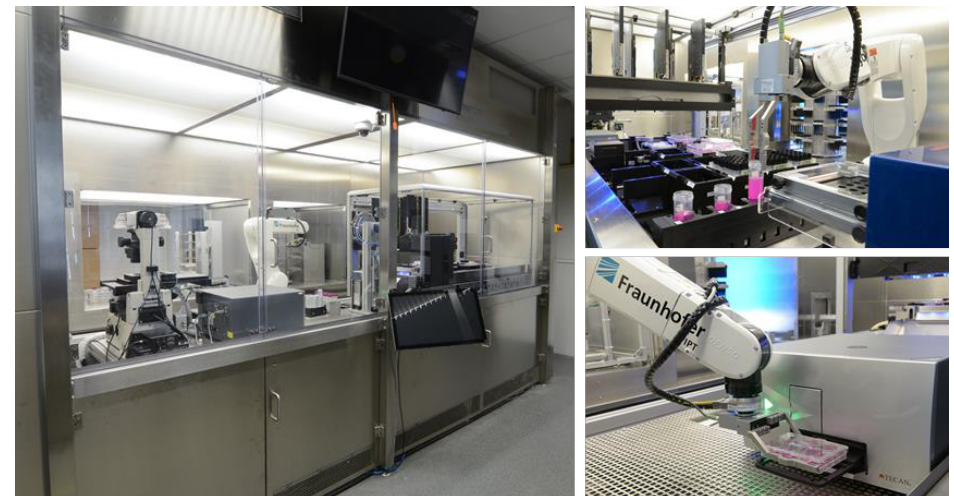
Figure 1. Photos of the StemCellDiscovery. Left: overview of the automated, robot-assisted platform housed in a cleanroom cabinet. Right top: robot placing a 50 mL tube onto the deck of the liquid handling unit (LHU). Right bottom: robot placing a six-well plate into the plate reader.